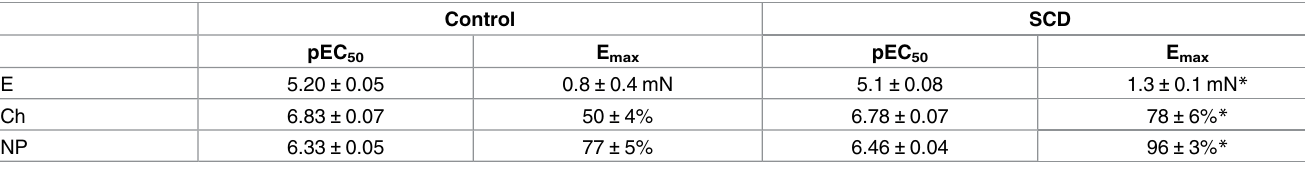
Table 2. Potency (pEC 50 ) and maximal response (E max ) values obtained from concentration–response curves for phenylephrine (PE; 10 − 8 to 3 x 10 − 4 M), acetylcholine (ACh; 10 − 9 to 10 − 5 M), and sodium nitroprusside (SNP; 10 − 8 to 10 − 5 M) in cavernosalstrips from control and SCD mice. Data represent the mean ± S.E.M. for 6 to 9 mice in each